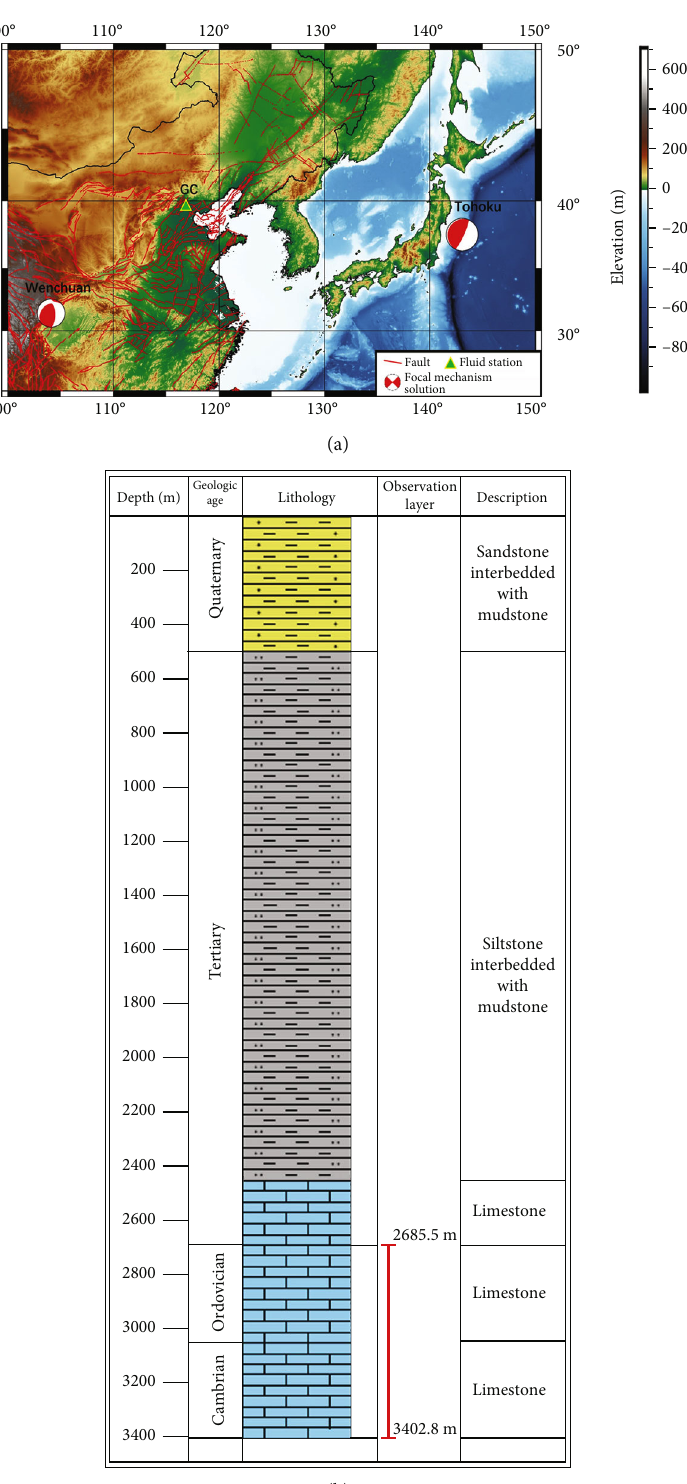
Figure 2: (a) Location of the North China Platform, the position of the groundwater well Gaocun (green triangle, GC: Gaocun), and the epicenters of the 2008 M w 7.9 Wenchuan earthquake and the 2011 M w 9.1 Tohoku earthquake (from Global CMT). The “ beach balls ” show the focal mechanism for the 2 huge earthquakes. Red lines indicate the surface faults [23]. (b) Well logs of Gaocun. The red lines and numbers indicate the depth of the observation aquifer (the screened section). For analyzing the impaction of major rocks in the observation aquifer, we neglected those rocks with small amount (references: Seismic Monitoring Records of China; Seismological Press, Beijing, 2004 (in